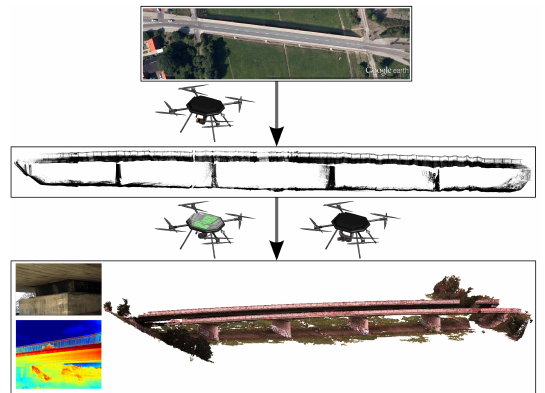
Figure 3: Scenario from an unknown area or building (top) via the first exploration with a laser scanning range finder mounted on an UAV (mid) to the fully explored building (bottom). Results of the exploration may be dense point clouds and detail images for damage detection.